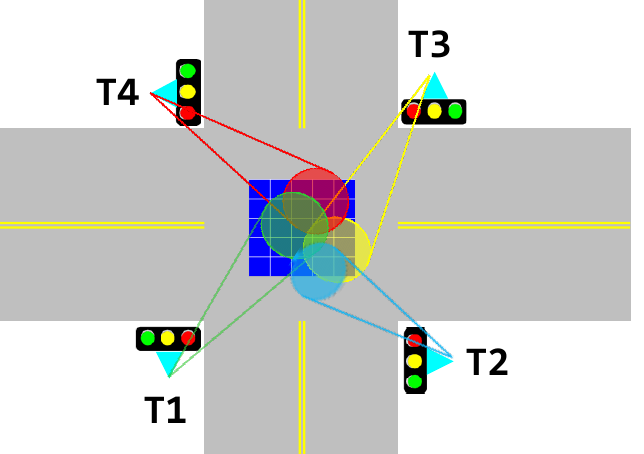
Figure 9. Scenario showing the power losses caused by positioning inaccuracy between the PTXs and